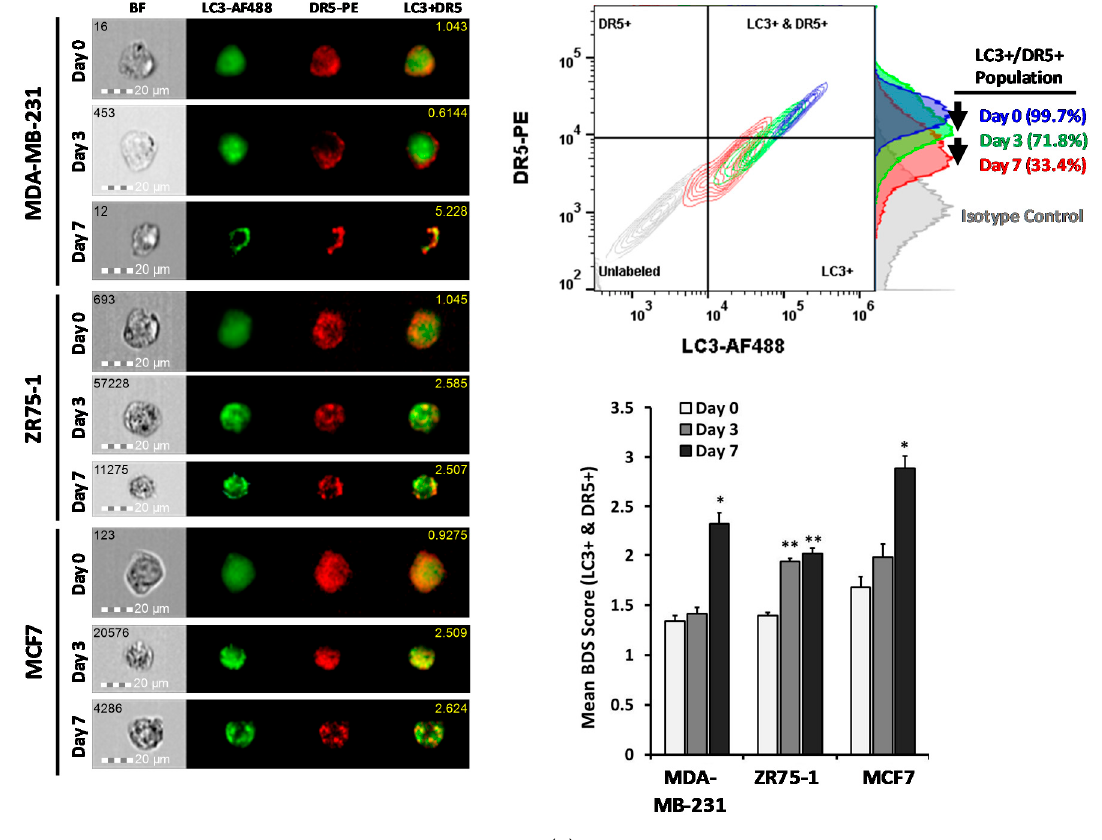
Figure 3. Non-adherent cultured cells increased the autophagic flux as measured by the LC3 I-II turnover and autolysosomal formation. ( a ) Western blot analysis of the BCC lines, cultured in monolayer or suspension condition up to seven days. Cell lysates were analyzed for LC3-I (top band) and LC3-II (bottom band), p62, and GAPDH. LC3-II to LC3-I relative protein ratio indicating the LC3 turnover compared to the monolayer (day 0) (mean ± SEM; n = 3; * p < 0.05). Relative expression of the p62 to the monolayer-cultured cells (mean ± SEM; n = 3; * p < 0.05). ( b ) Images of the MDA-MB-231, ZR75-1 and the MCF7 cells cultured in monolayer (day 0) or suspension for three or seven days, captured using imaging flow cytometry. Figure shows brightfield (BF), LC3-AF488 (green), LAMP1- PE (red), and a composite image of the co-localization of LC3 and LAMP1 (yellow). Autophagosomes are indicated with red arrows and the co-localization of LC3 and LAMP1, representing the autolysosome formation, is shown with yellow arrows. Corresponding bright detail similarity score between the LC3-AF488 and the LAMP1-PE puncta is shown in yellow. (Single fluorophore controls are provided in Figure S4). Population analysis of cells undergoing autophagy (high autophagosome counts ( ≥ 7 LC3+ spots per cell)) and autophagic flux (high co-localization of LC3-AF488 and LAMP1- PE (bright detail similarity score ≥ 1.8)) (mean ± SEM; n = 3; * p < 0.05, ** p < 0.01 relative to